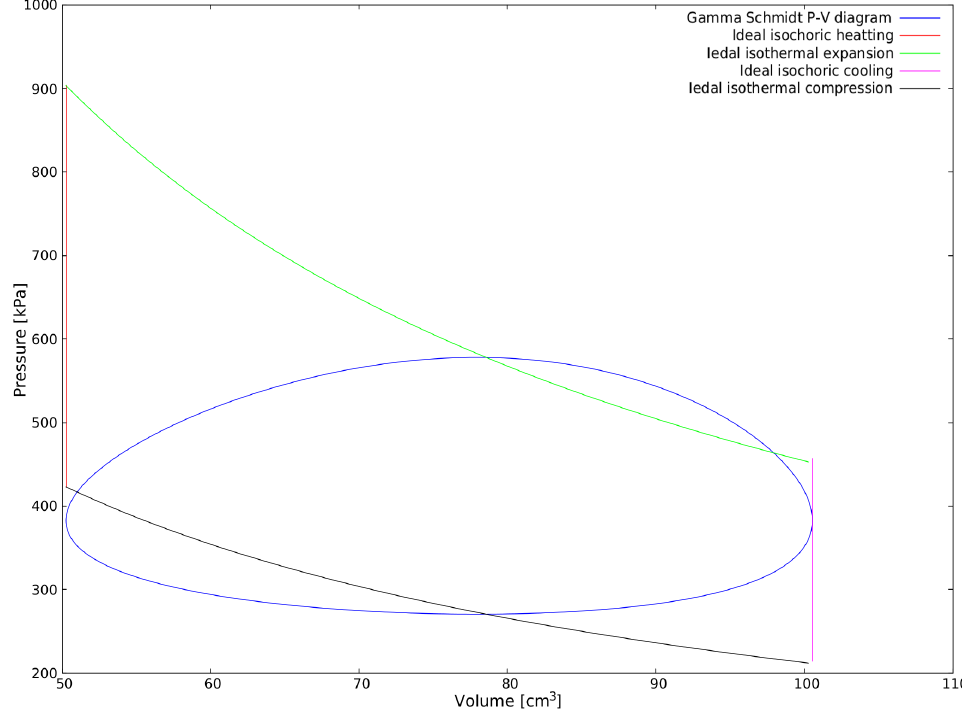
Figure 12. Gamma with crank P-V